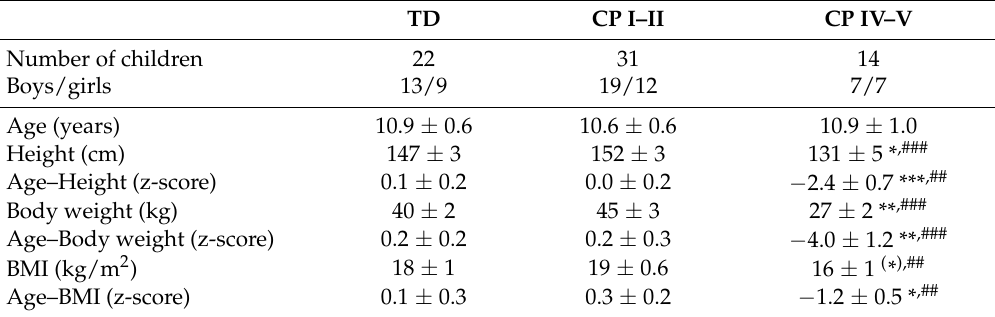
Table 1. Subject characteristics.